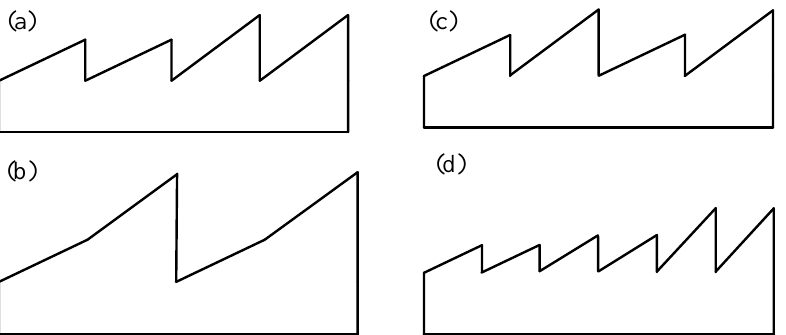
Figure 2. Convex dual-blaze grating. ( a ) Dual-panel blazed structure [28]. ( b ) Dual-angle blazed structure [28]. ( c ) Dual-blaze angle structure [31]. ( d ) Schematic diagram of multi-blazed grating groove structure [32].